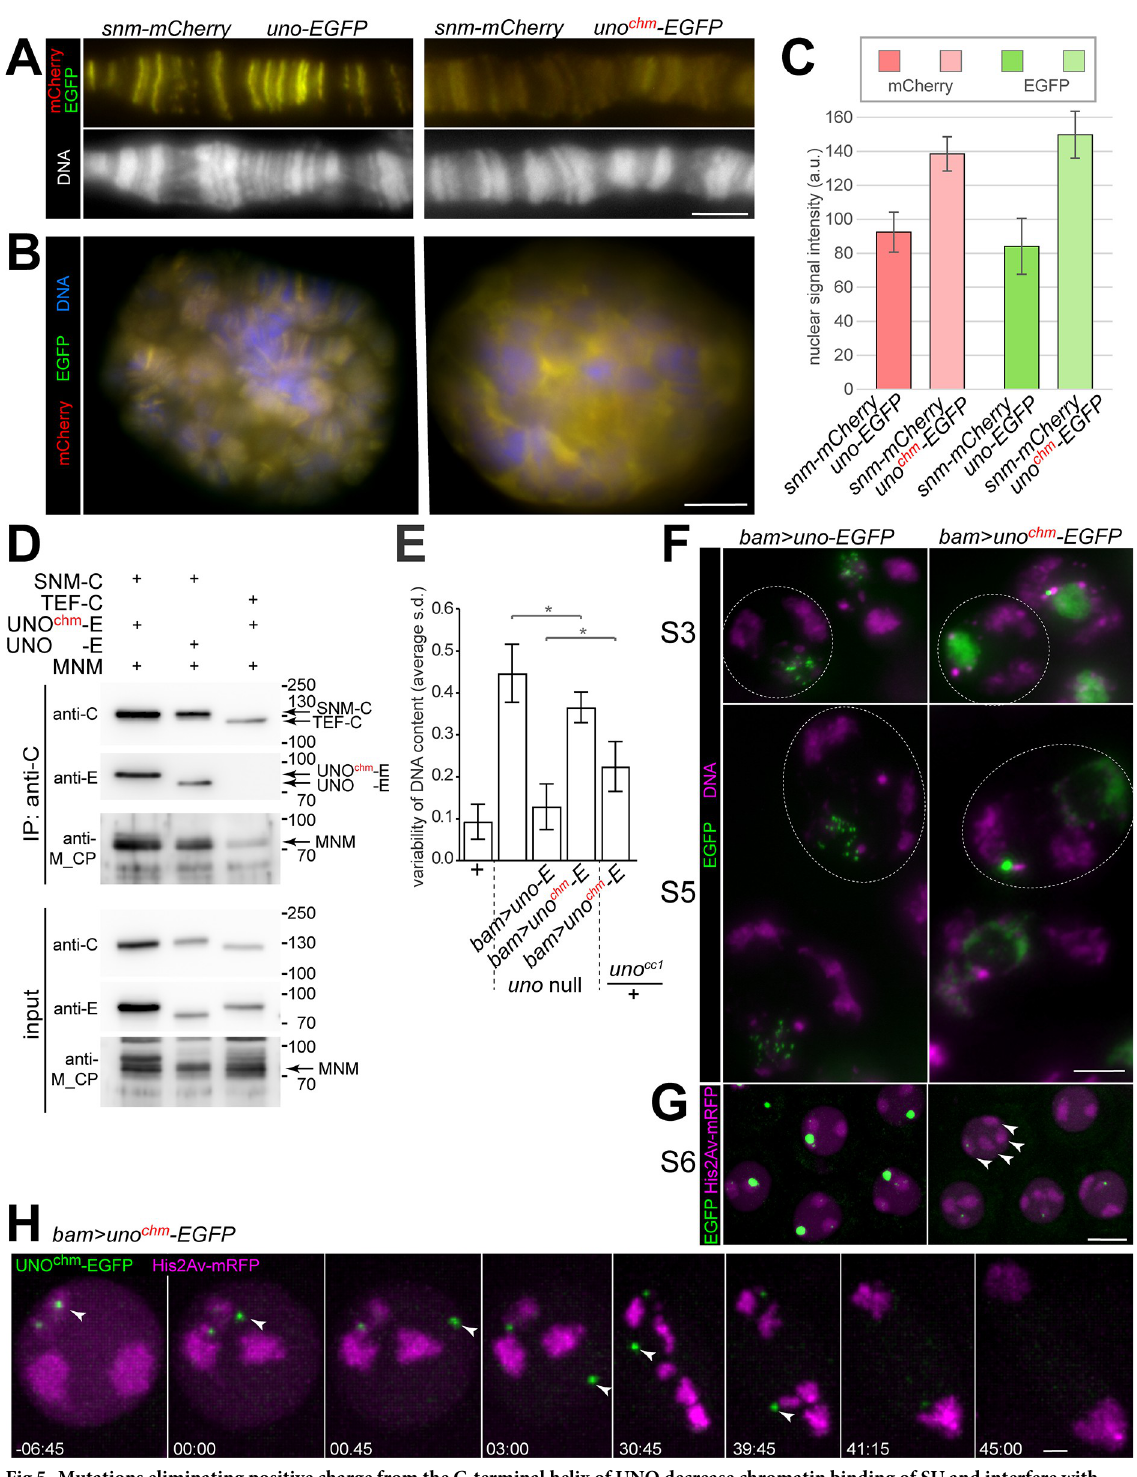
Fig 5. Mutations eliminating positive charge from the C-terminal helix of UNO decrease chromatin binding of SU and interfere with normal chromosome conjunction during meiosis. ( A ) After co-expression with SNM-mCherry in larval salivary glands, UNO chm -EGFP with a mutant C-terminal helix is still strictly co-localized with SNM-mCherry, as indicated by yellow signals, but its association with polytene chromosome spreads is much weaker in comparison to wild-type UNO-EGFP. UASt transgenes and Sgs3-GAL4 were used for salivary gland- specific expression. ( B , C ) Expression of SNM-mCherry and UNO chm -EGFP resulting with the UASt transgenes and Sgs3-GAL4 was stronger